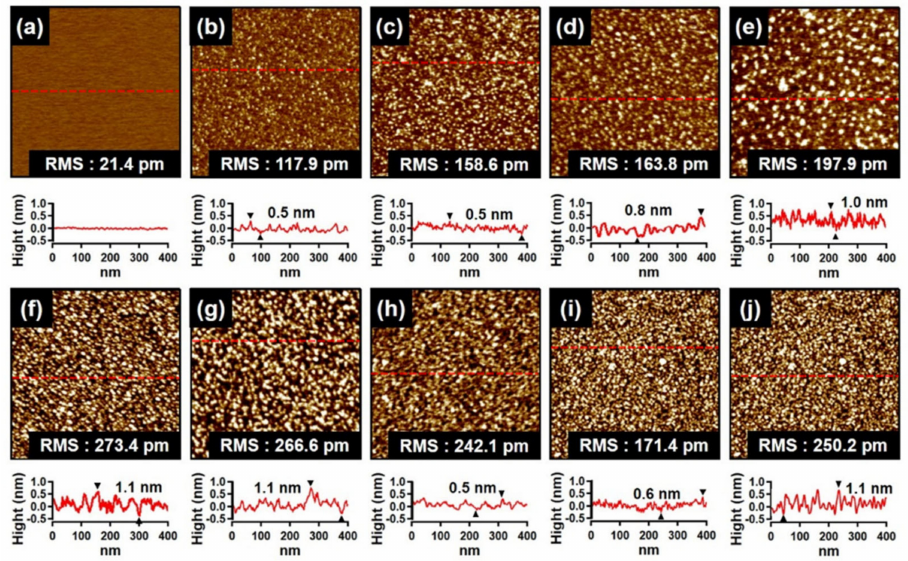
Figure 1. AFM topography images and line − scans of ( a ) cleaved mica and PDA/mica prepared by immersion for different times: ( b ) 60, ( c ) 90, ( d ) 120, ( e ) 150, ( f ) 180, ( g ) 210, ( h ) 300, ( i ) 420, and ( j ) 540 s, respectively. The line − scans are presented below each topography